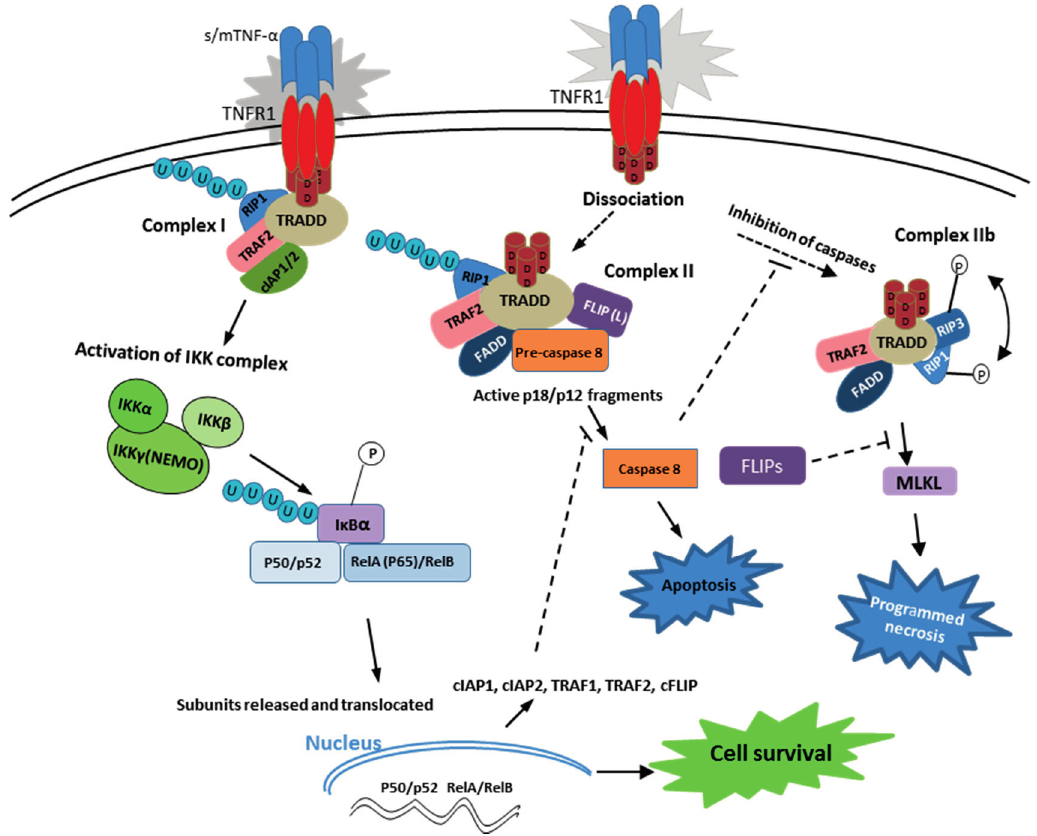
Figure 1. Multiple forms of TNFR1 signaling activation are mediated through intracellular protein complex assembly. The trimeric TNF- α engagement of TNFR1 leads to cellular apoptosis or cell survival via the distinct complex signaling